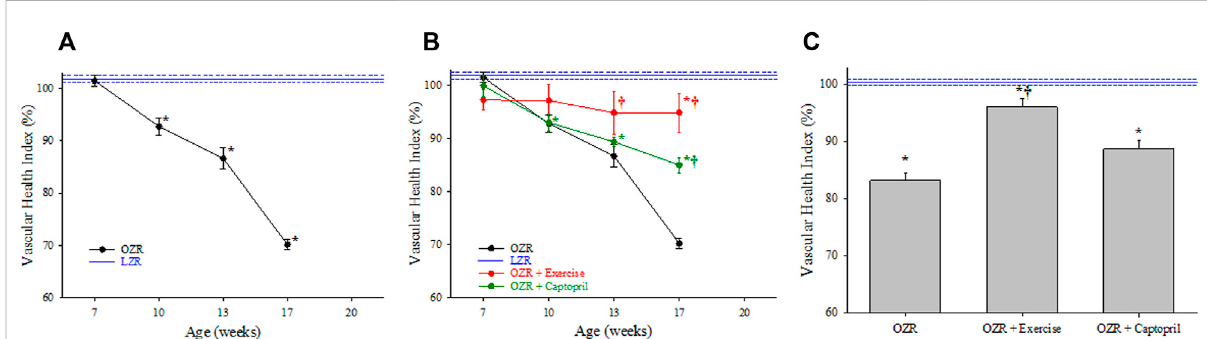
FIGURE 2 Data describing the 5-parameter determination of Vascular Health Index (VHI) within the peripheral/skeletal muscle microcirculation. Data (mean ± SE) are presented for OZR over the age ranges of the present study (Panel (A) ) or the impact of chronic interventions with either exercise or captopril administration (Panel (B) ). Panel (C) presents the aggregate VHI from the different animal groups where all ages have been compiled into onedatapoint.VHIfromLZRissetto100%,byde fi nition.* p < 0.05vs.LZRatthatage; † p < 0.05vs.untreatedOZRatthatage.Pleaseseetextfor details.